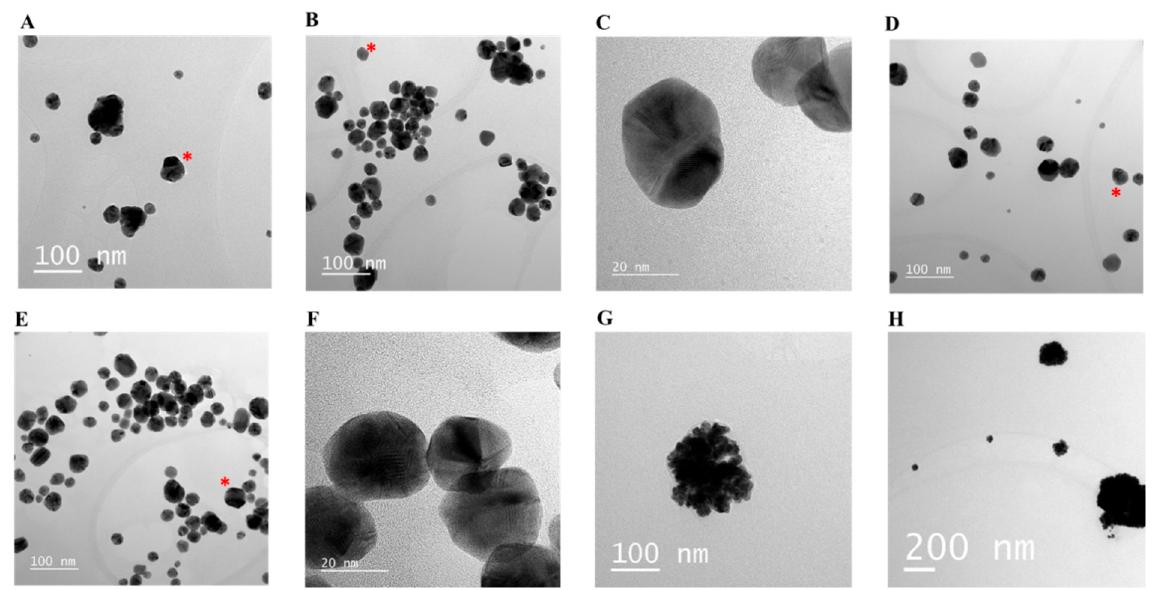
Figure 4. Structural analysis of nanoparticles by TEM. ( A – C ): TEM micrographs of nanoparticles synthesized by soluble extracts from pUC19-Vec cells collected after centrifugation at 3000× g ( A ) and further at 17,000 g ( B , C ). ( D – F ): TEM micrographs of nanoparticles synthesized by soluble extracts from pUC-Syn cells collected after centrifugation at 3000 × g ( D ) and further at 17,000 g ( E , F ). ( G , H ): TEM micrographs of nanoparticles synthesized by pUC-Syn whole cells. * irregular- shape or cylindrical nanoparticles. Table 1. Comparison of nanoparticle size.